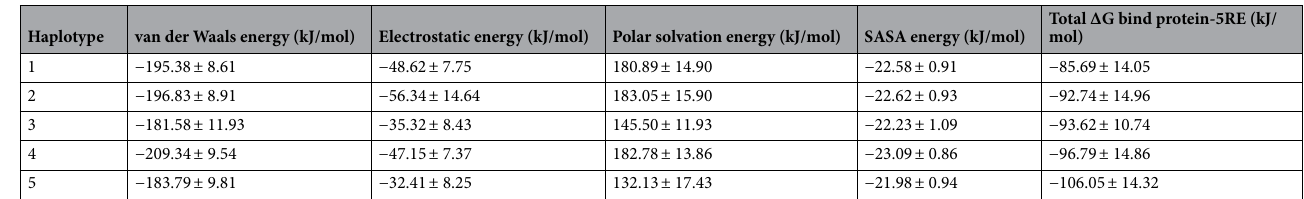
Table 4. MMPBSA energy parameter contributions to the total binding free